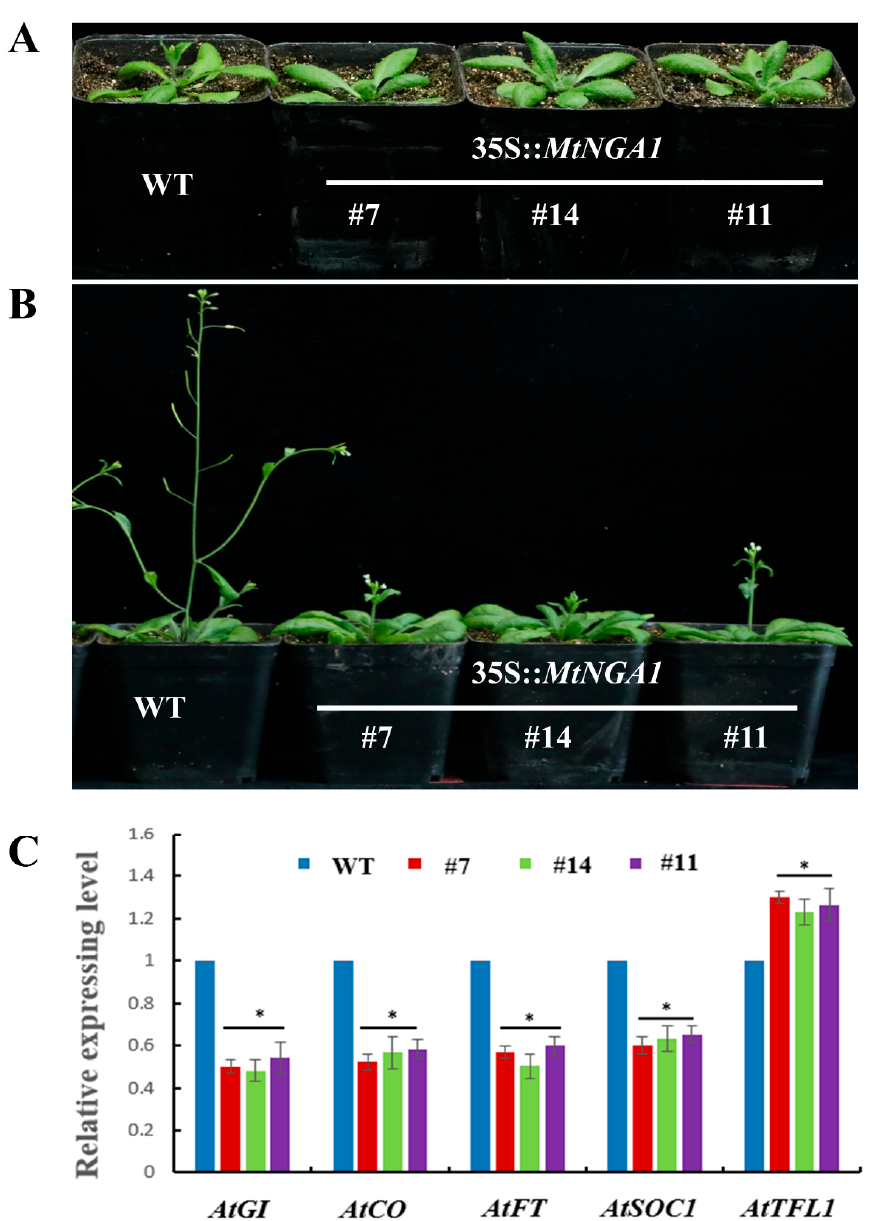
Figure 5. Comparative analysis of flowering time between transgenic and wild-type Arabidopsis. ( A ) Phenotype of transgenic Arabidopsis expressing the MtNGA1 gene and wild-type Arabidopsis at 30 days. ( B ) Comparison of the phenotypes of transgenic Arabidopsis and wild-type Arabidopsis at 40 days. ( C ) Expression analysis of genes related to flowering in transgenic and wild-type (WT) plants by qRT-PCR. GI, GIGANTEA. CO, CONSTANS. FT, Flowering locus T. SOC1, SUPPRESSOR OF OVEREXPRESSION OF CONSTANS 1. TFL1, TERMINAL FLOWER 1 . The values are the means ± SD ( n = 3). * indicates significant differences of the means at p < 0.05 between each level in transgenic lines and WT plants determined by expression analysis ( n =